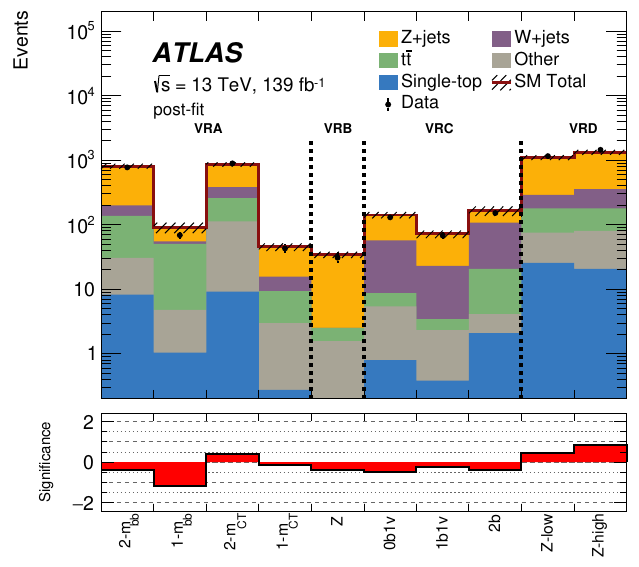
Figure 4 . Comparison between observed and post-fit predicted background yields for the validation regions. The ratio plot represents the statistical significance [130] of the discrepancy between the observed and predicted value. The “Other” category includes contributions from diboson and t ¯ t + W/Z/H production. The shaded band represents the total uncertainty of the background